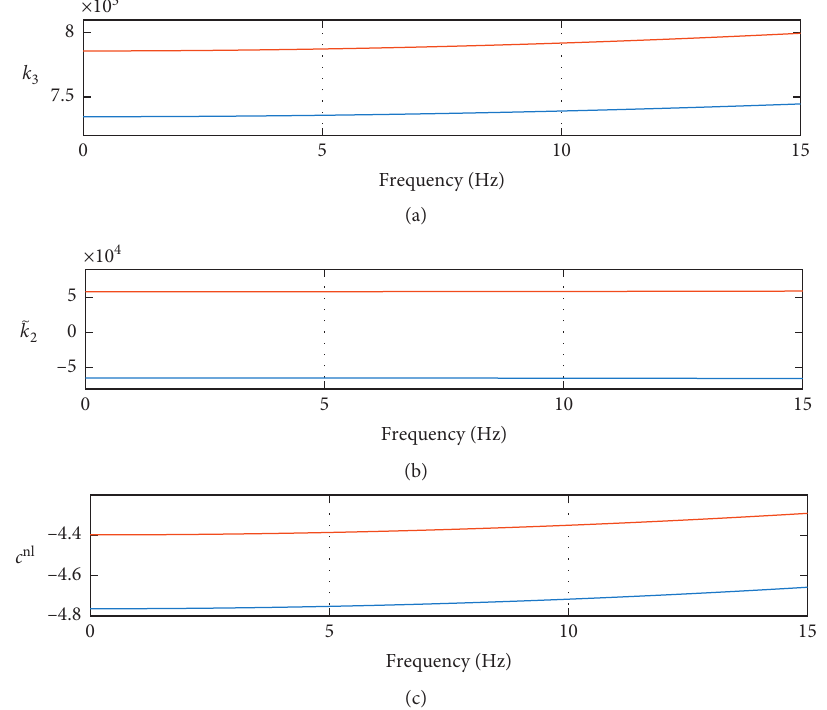
Figure 21: Real parts of the identified coefficients as frequency-dependent quantities. Blue line: NSI with reference position z ∗ � z ∗ line: NSI with reference position z ∗ � z ∗ + . (a) Coefficient k